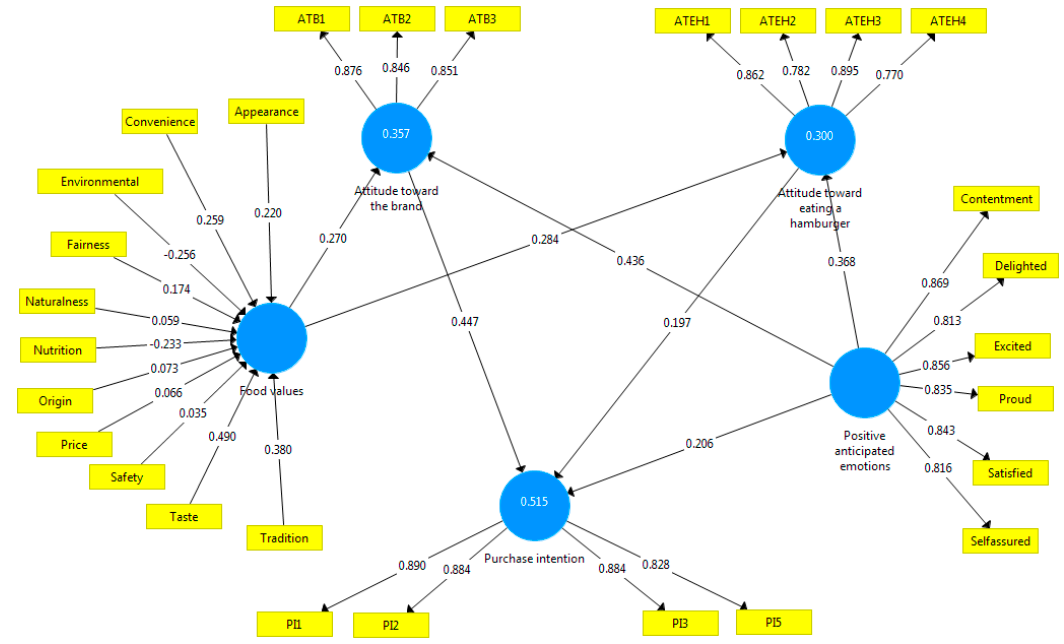
Figure 2. PLS analysis results.